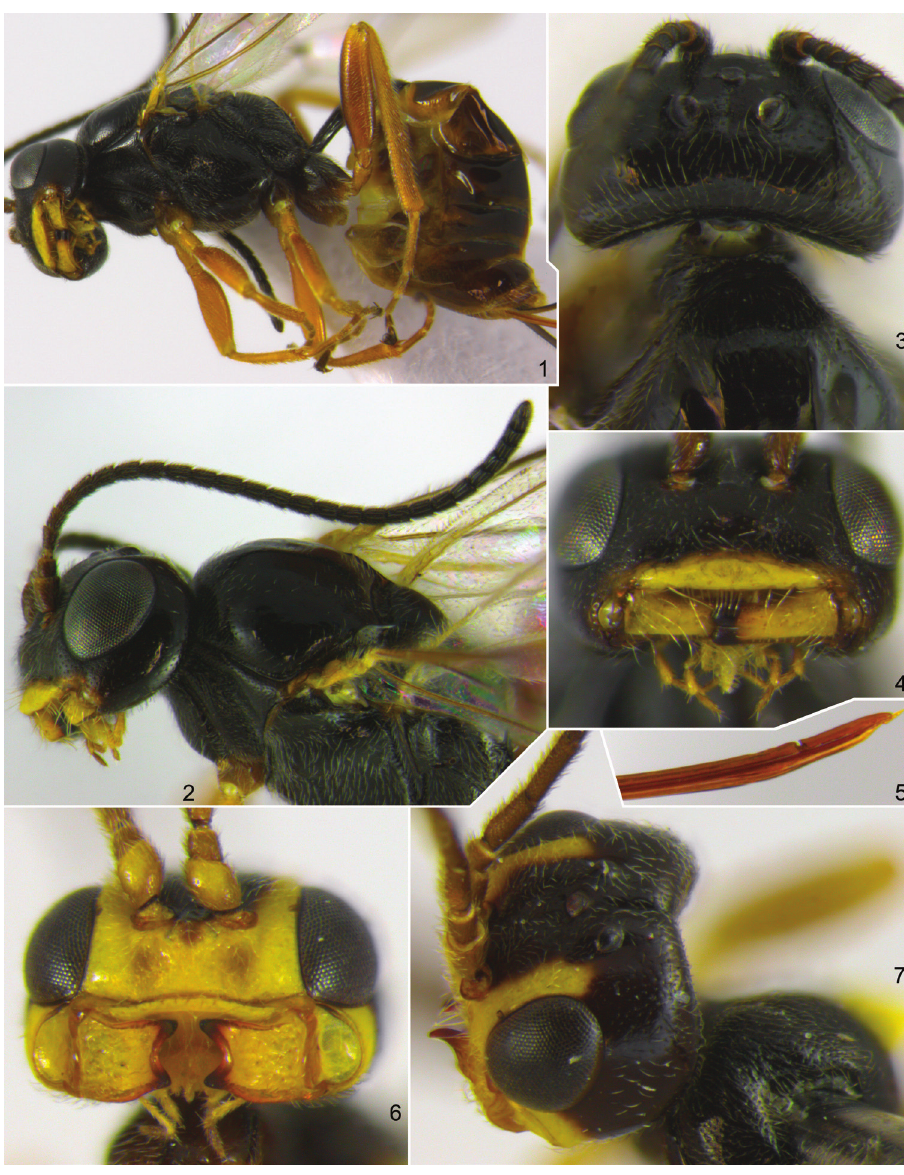
Figures 1–7. Gelanes horstmanni sp. n., holotype female ( 1, 2, 4, 5 ) and paratype male ( 3 ). 1 body, lateral view 2 head with antenna and mesosoma, dorso-lateral view 3 head, dorsal view 4 head, antero- ventral view 5 apex of ovipositor, lateral view. Idiogramma comstockii , female 6 head, antero-ventral view 7 head, dorso-lateral